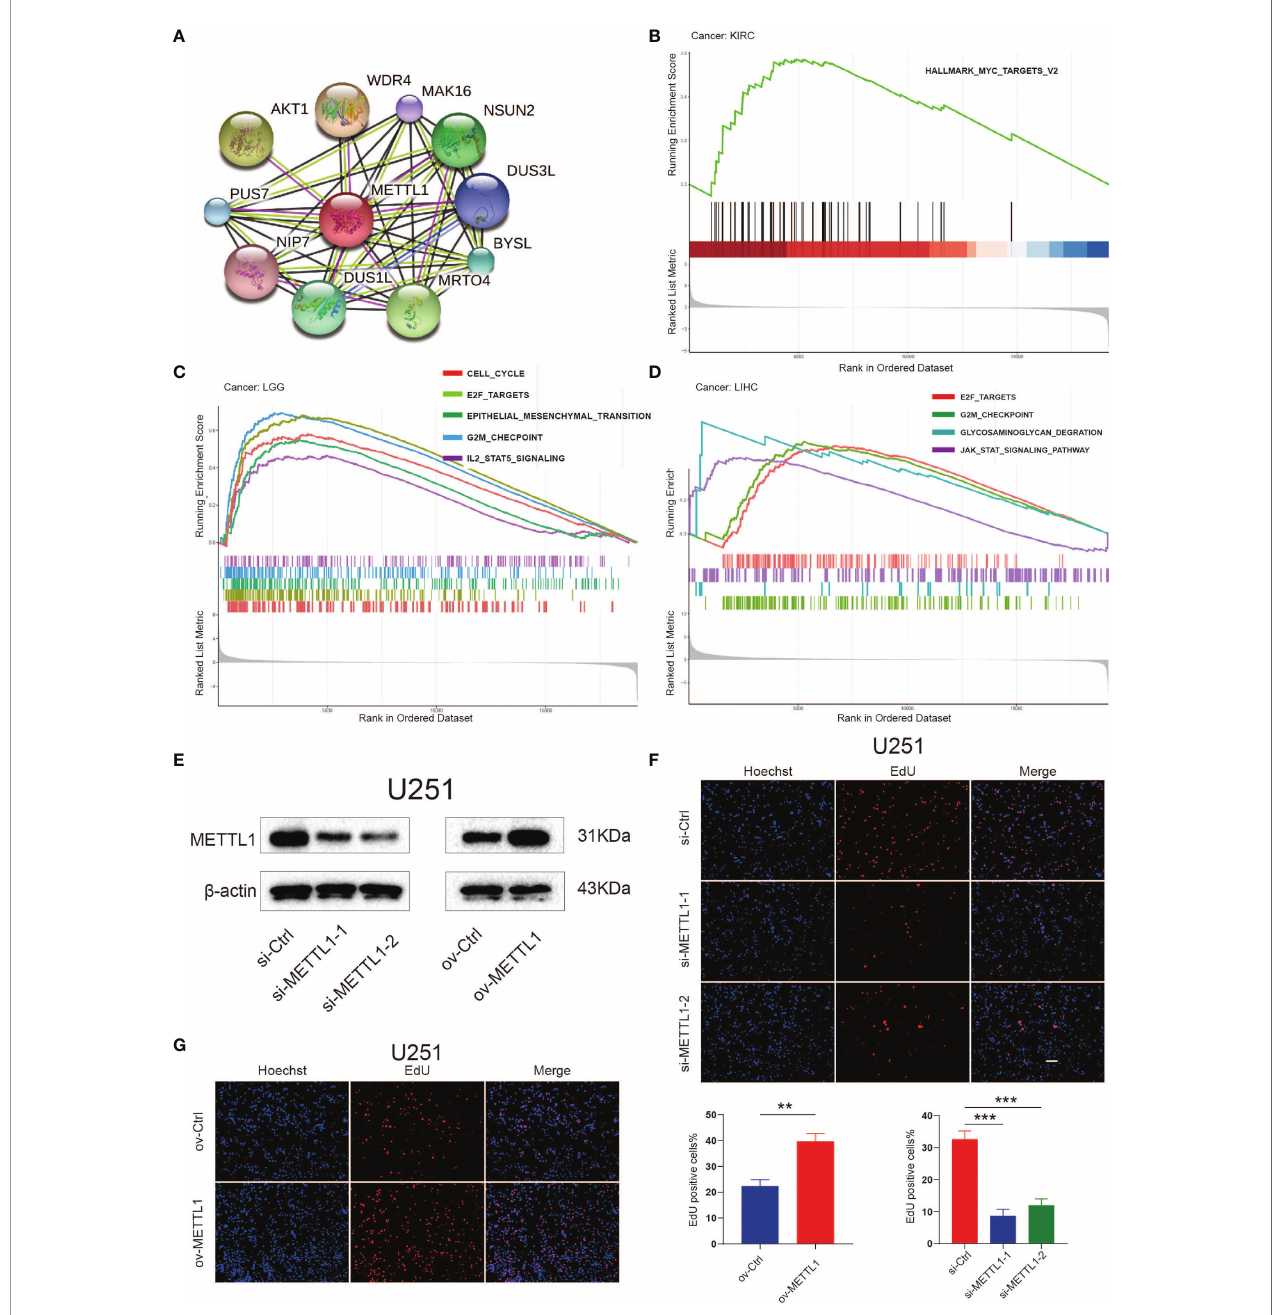
FIGURE 5 | Functional analyses of METTL1. (A) PPI network visualized the potential proteins that interact with METTL1 and play a biological regulating function of METTL1. Line colors indicates the prediction methods; “ green ” indicates neighborhood, “ red ” indicates gene fusion, “ blue ” indicates co-occurrence, “ black ” indicates co-expression, “ pink ” indicates experiments, “ wathet ” indicates databases, “ grass green ” indicates textmining. (B-D) GSEA results based on Hallmark and KEGG dataset among KIRC, LGG, and LIHC. (E) Western blot analysis was performed to assess the expression levels of METTL1. b -actin was used as a loading control. (F, G) EdU was performed in U251 transfected si-control, si-METTL1#1, si-METTL1#2, vector and ov- METTL1 cells (scale bar = 100 m m). ** means P < 0.01; *** means P <